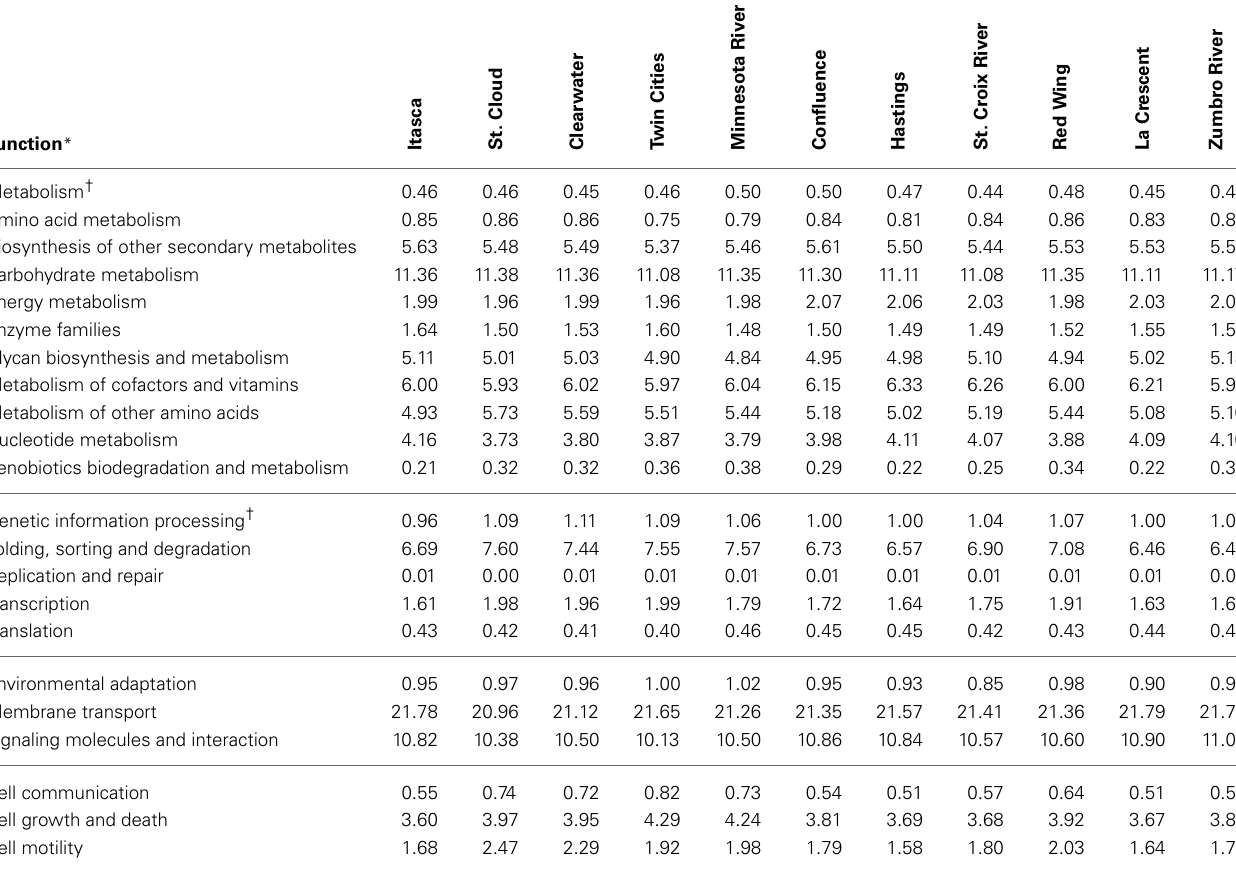
Table 1 | Percentages of predicted sequences assigned to second tier KO categories in the metagenomic